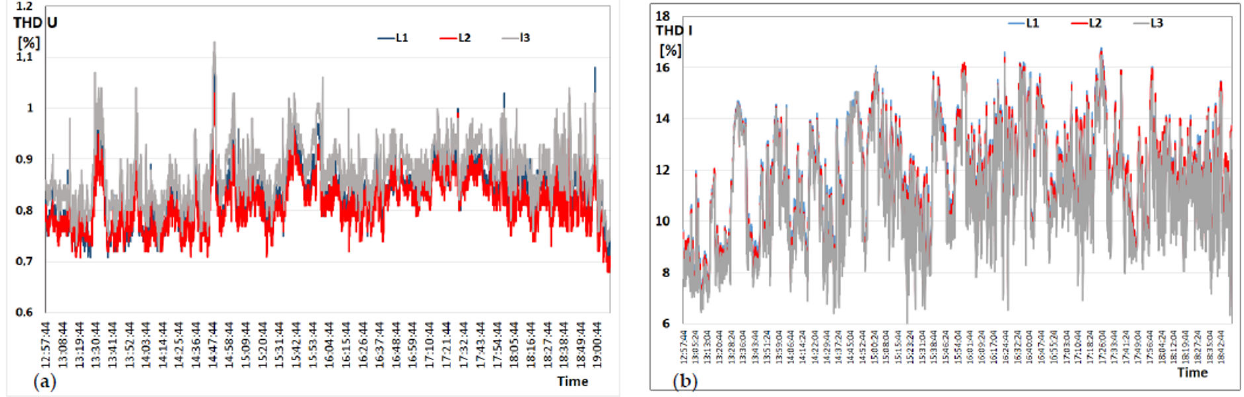
Figure 2. Changes in the harmonic distortion of the voltage THDU ( a ) and current THDI ( b ) recorded at point